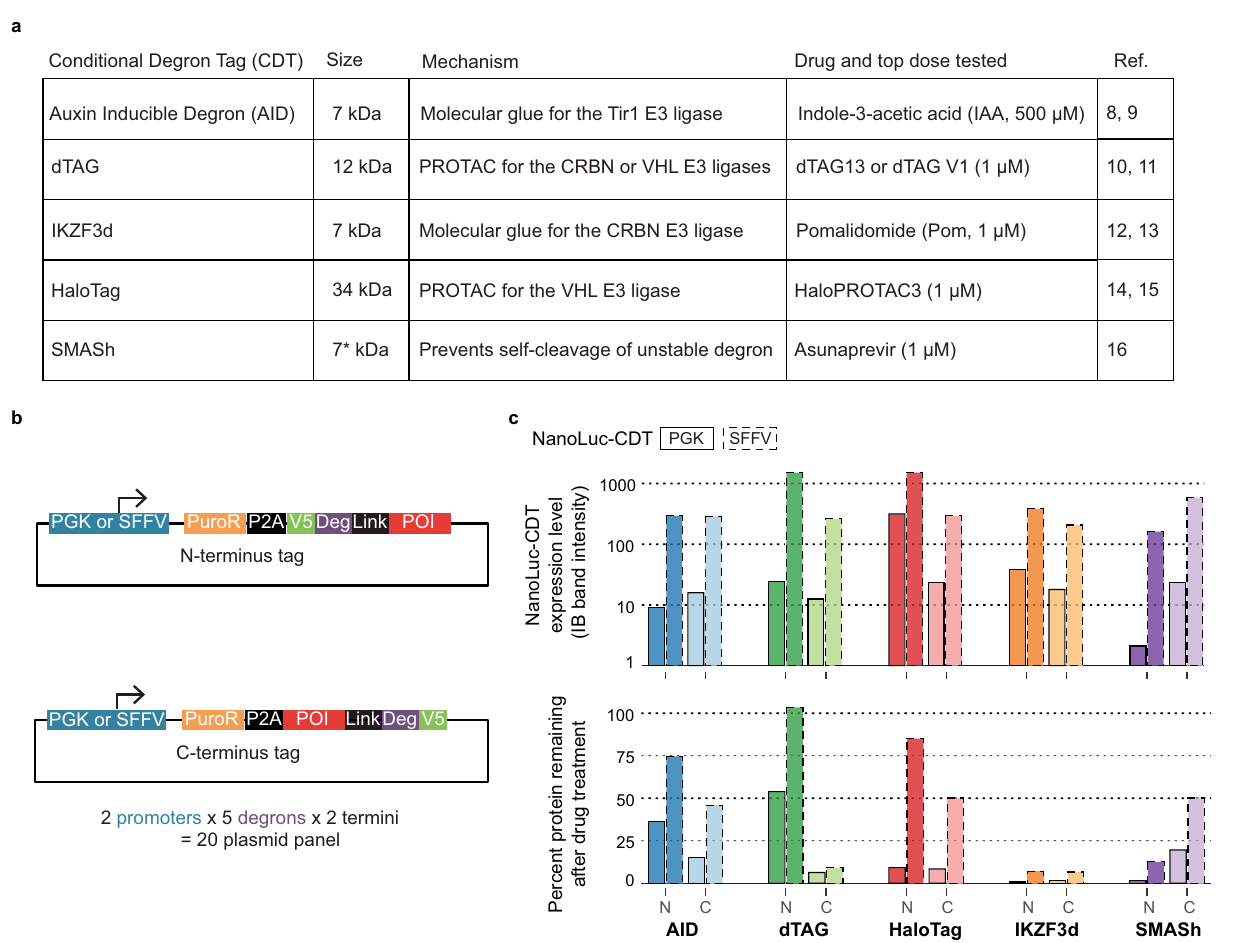
Fig. 1 | A vector panel to systematically evaluate conditional degron tag (CDT) fusion protein expression, degradation, and function. a Summary table of the fi ve CDTs evaluated in this work. Each CDT, except for small-molecule-assisted shut-off (SMASh), functions through reprogramming an E3 ubiquitin ligase with a smallmoleculetorecognizethedegronfusionprotein.SMAShfusionproteinsself- cleave a degron tag; the addition of the small molecule blocks this self-cleavage. *The SMASh tag itself is 34kDa, but after self-cleavage, the stably-expressed (V5) tag is only 7kDa. b Plasmid design for systematically evaluating CDT fusions to a proteinofinterest(POI).WeemployedaP2Acleavagesitetoseparateanantibiotic- resistancegene (PuroR) andthe fusionprotein.A V5epitopetagenablesdetection and quantitation of the fusion protein by western blot. A rigid linker (EAAK 3 , Link)